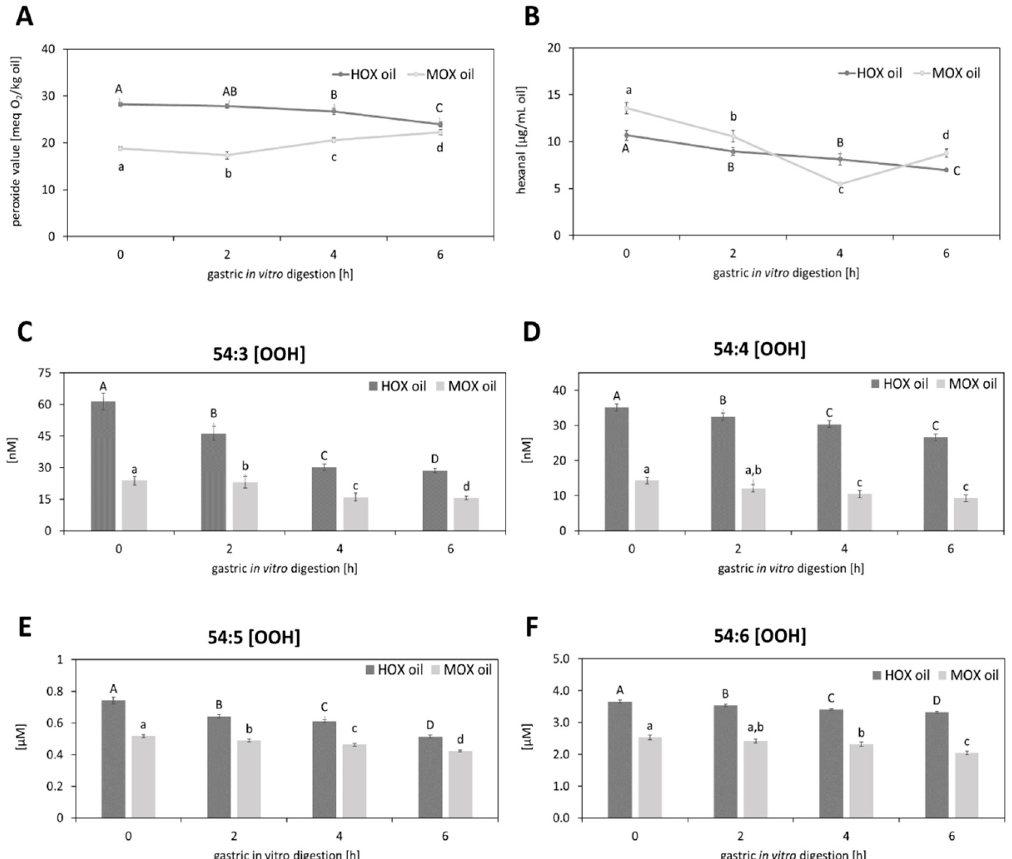
Figure 2. E ff ects of the gastric in vitro digestion on ( A ) the peroxide value (meq O 2 / kg oil), ( B ) the amount of hexanal ( µ g / mL) and on the hydroperoxidized triacylglycerols (OOH) ( C ) 54:3 (OOH), ( D ) 54:4 (OOH), ( E ) 54:5 (OOH), and ( F ) 54:6 (OOH) in the moderately and the highly oxidized grape seed oils. Statistically significant di ff erences between the time of digestion (0, 2, 4, 6 h) for each oil are indicated with di ff erent letters ( n = 3, One-Way-ANOVA, Holm–Sidak, p < 0.05). Capital letters indicate the significant di ff erences between the time of digestion of the H OX oil and lowercase letters mark significant di ff erences between the time of digestion of the M OX oil.